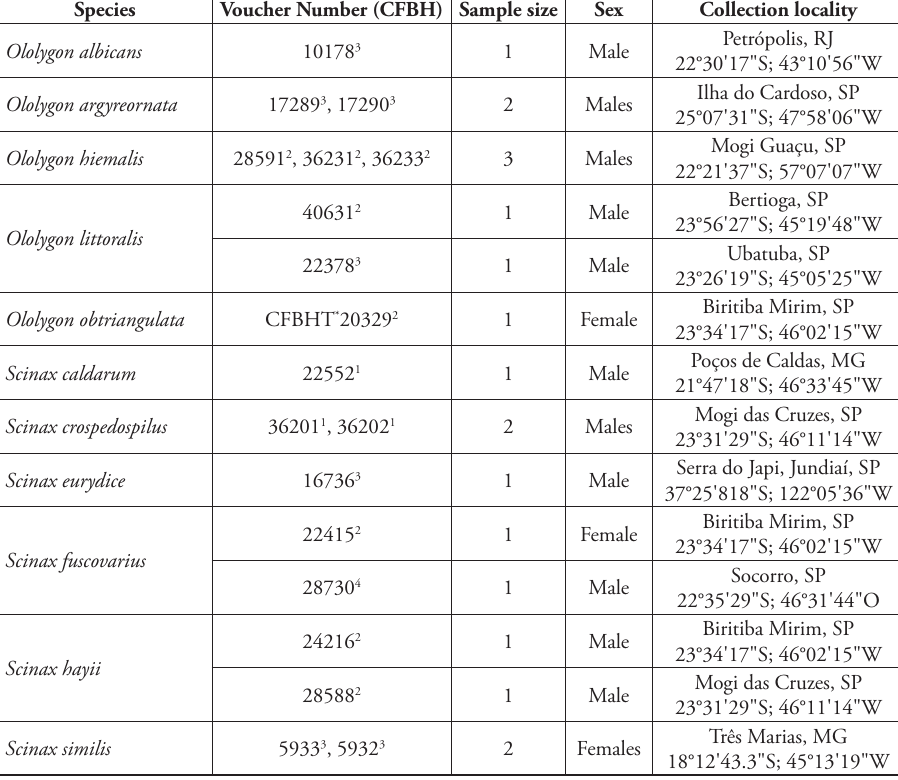
Table 1. Analyzed species, voucher number (CFBH), sample size, sex, and collection locality. Species Voucher Number (CFBH) Sample